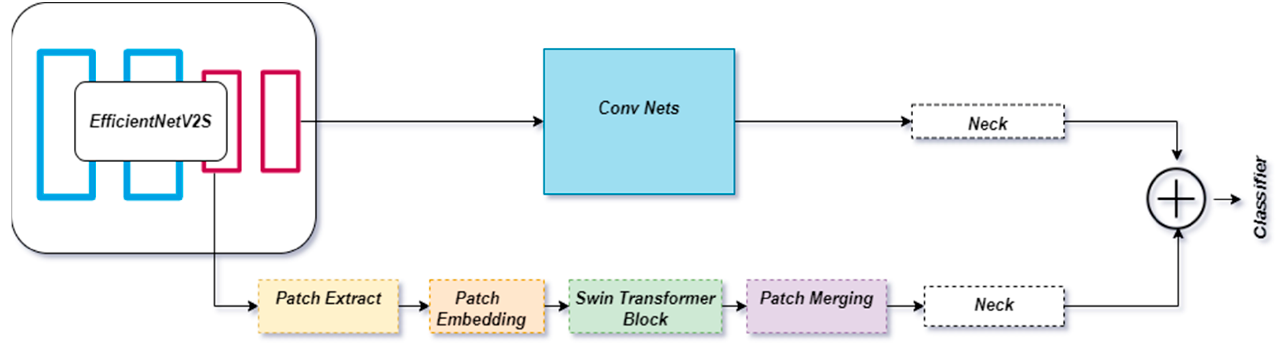
Figure 6. Workings of the proposed ensemble model.